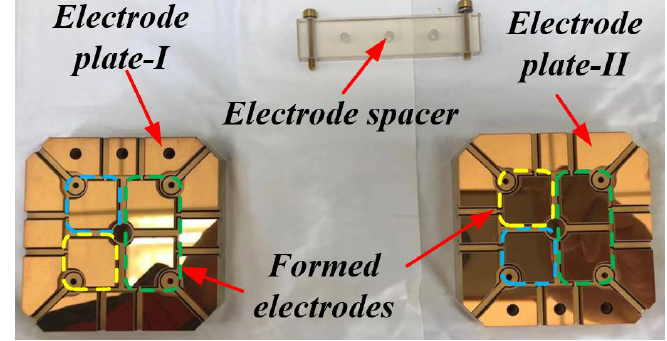
Figure 7. Components of an electrode housing.